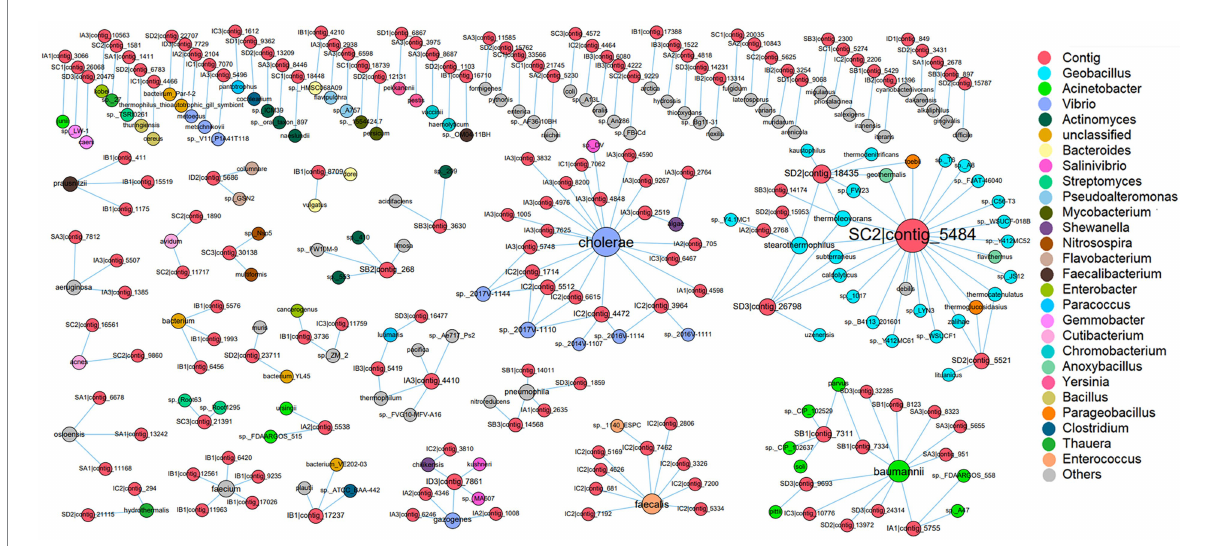
FIGURE 4 The host prediction of virus. Within the network, viruses (contig level) are represented as red nodes, and prokaryotes (species level) are represented as other color nodes, each node color indicates a prokaryotic genus, and the relative size of nodes is proportional to the number of interactions between virus and prokaryote taxa identified. The edge between a virus node and a prokaryote node indicates their infection history which is recorded in the CRISPR arrays.